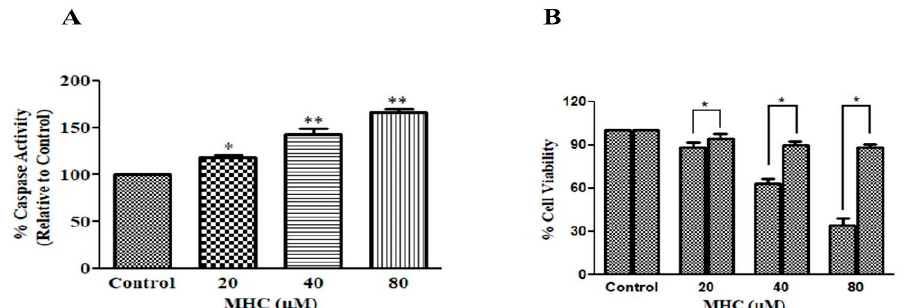
Figure 6. ( A ) Alteration in the levels of caspase-3 post treatment with MHC and ( B ) cell viability of MCF-7 cells treated with a caspase-3 inhibitor. * p < 0.05 and ** p < 0.01.